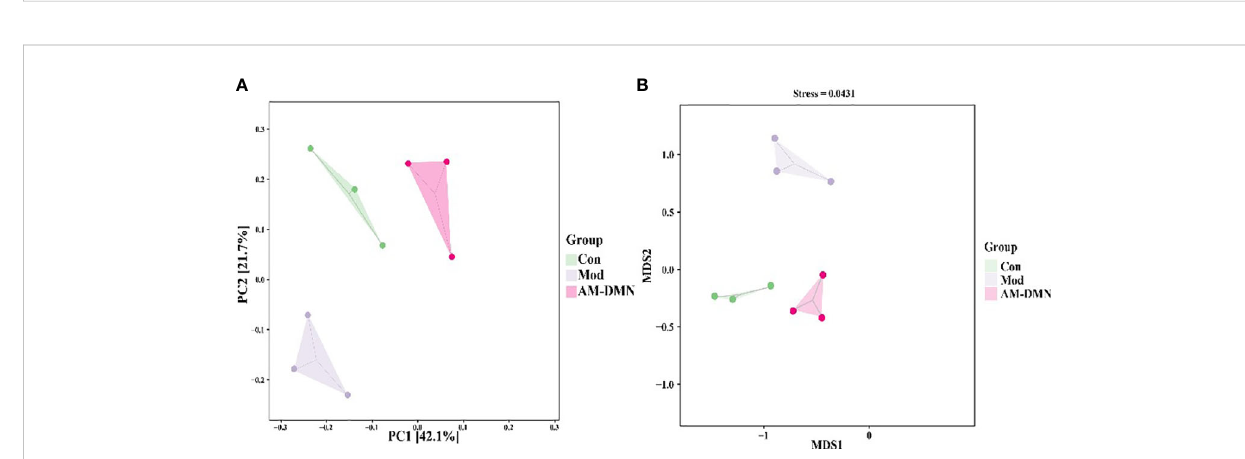
FIGURE 7 Effect of AM-ae on intestinal beta diversity of MGH rats (A) . PCA, (B)